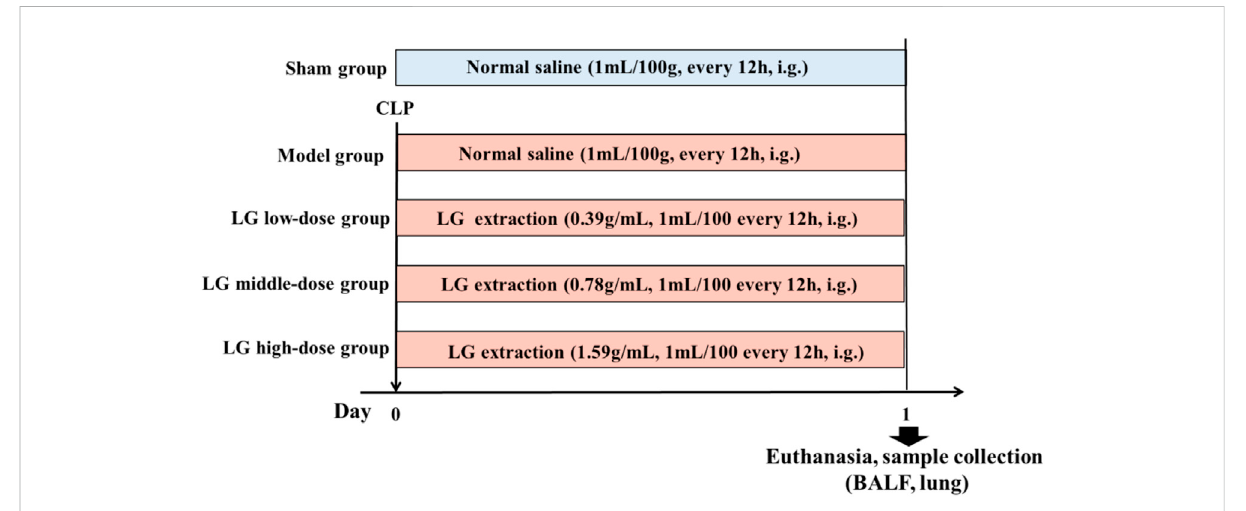
FIGURE 1 Grouping and dosing regimen. LG: Liang-Ge decoction, BALF: bronchoalveolar lavage fl